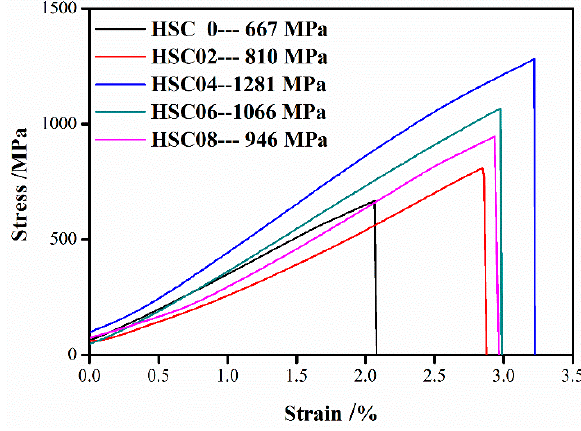
Figure 6. The stress–strain curve of the coating samples. Table 5. Tensile performance parameters of the coating samples.